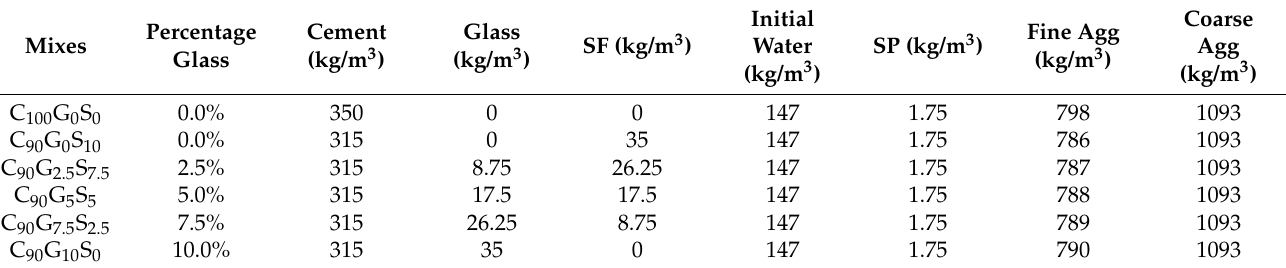
Table 3. Mix design for glass-blended silica-fume